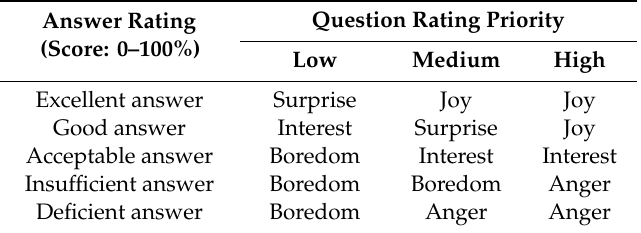
Table 9. Emotions organized according to the priority of the question and the score of the answer.